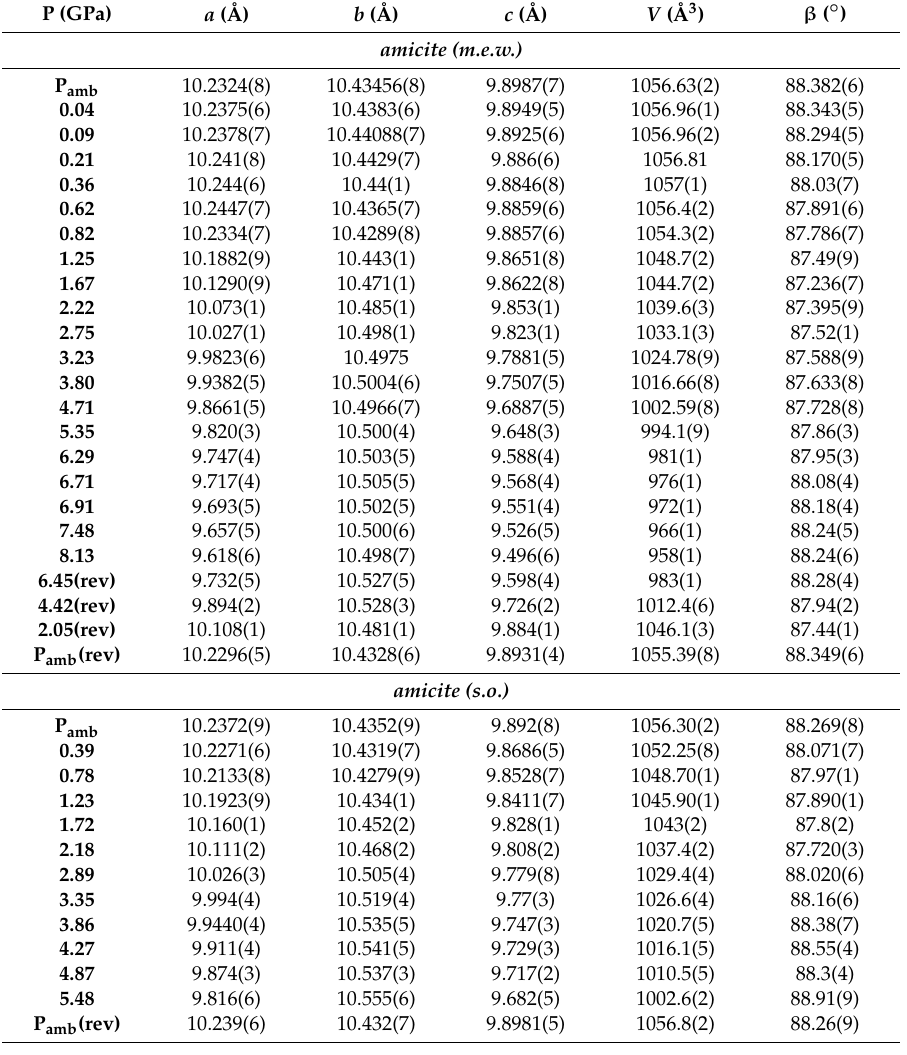
Unit-cell parameters of natural amicite at the investigated pressures, using (16:3:1) methanol:ethanol:water (m.e.w.) and silicon oil (s.o.) as pressure-transmitting media